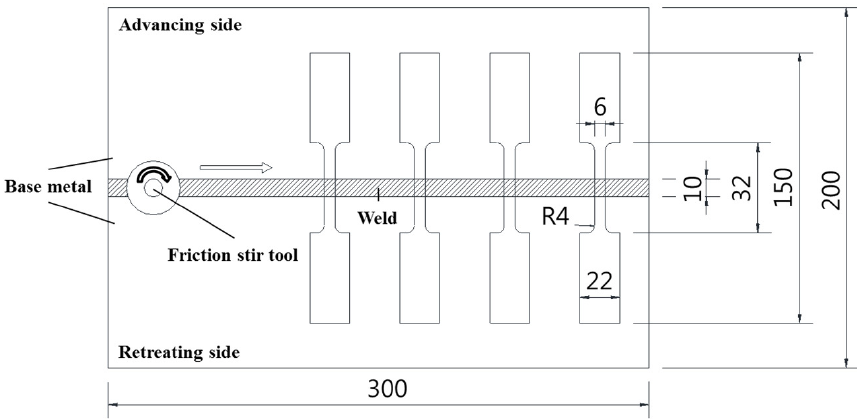
Figure 3. Configuration of FSW sheets and specimen preparation for tensile tests (units: mm).